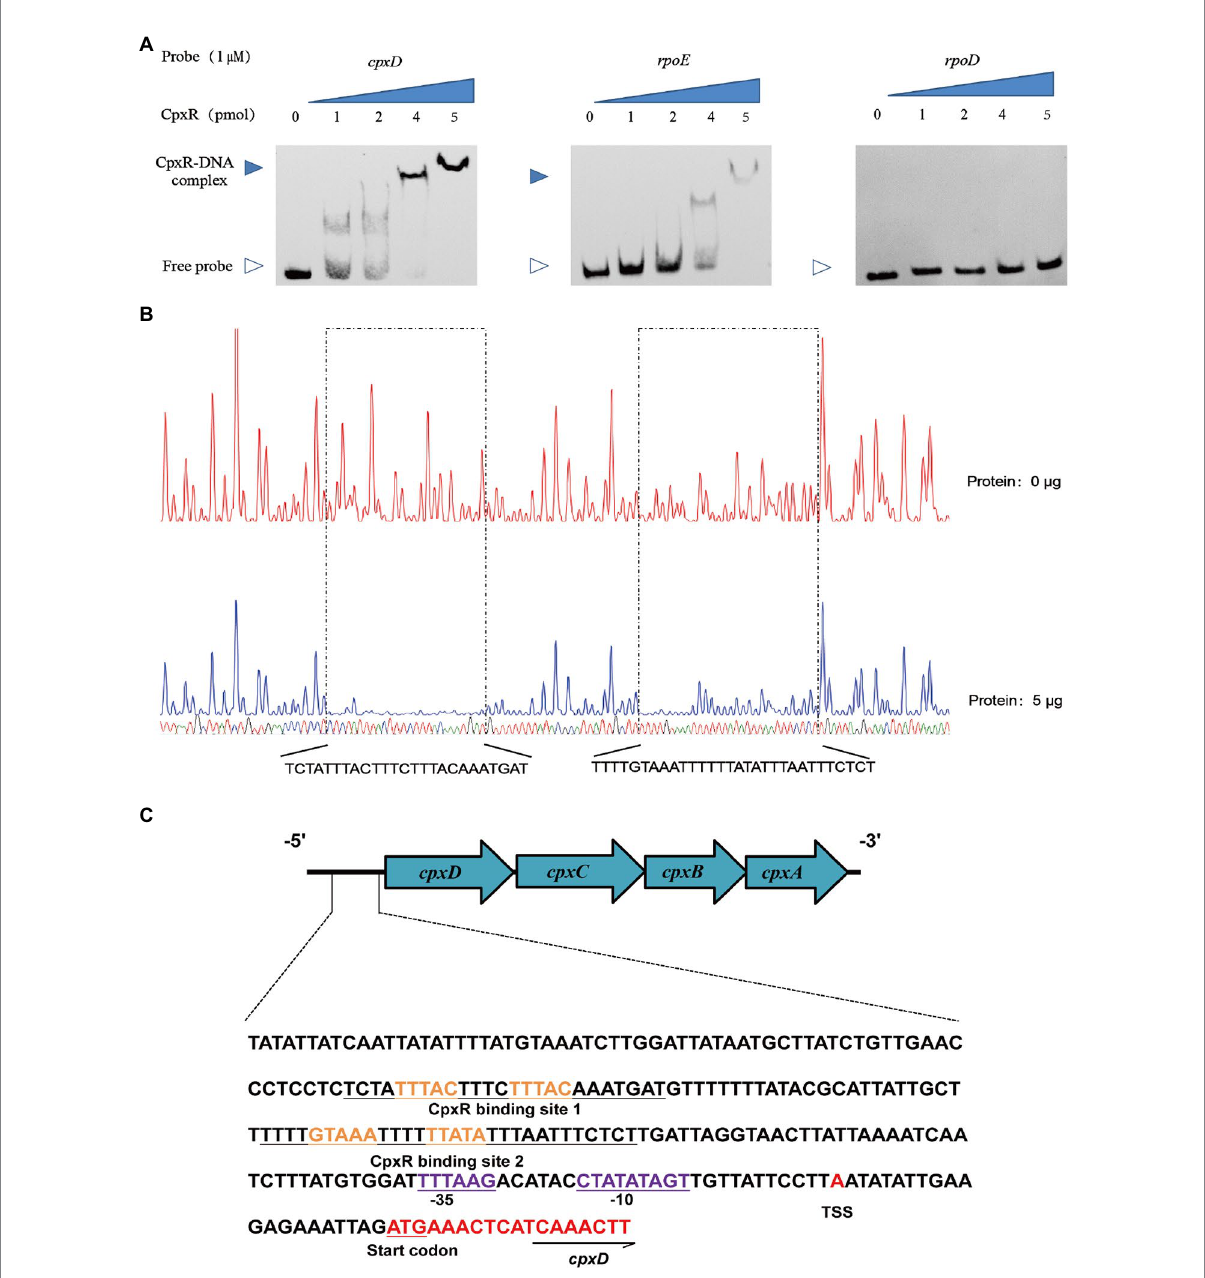
FIGURE 3 CpxR binds to the cpxD promoter region. (A) EMSAs performed with various concentrations of phosphorylated CpxR (0–4 pmol) and the promoter regions of cpxD , rpoE (positive control) and rpoD (negative control). (B) Mapping the CpxR binding sites in the cpxD promoter by DNase I footprinting. Protected regions were shown below the footprinting results. (C) Nucleotide sequences of cpxD promoter. CpxR-binding site was shown in blue nucleotides boxed in black, and − 35 box, − 10 box were underlined and shown in green. Start codon of cpxD was underlined and shown in red, and the TSS was shown in